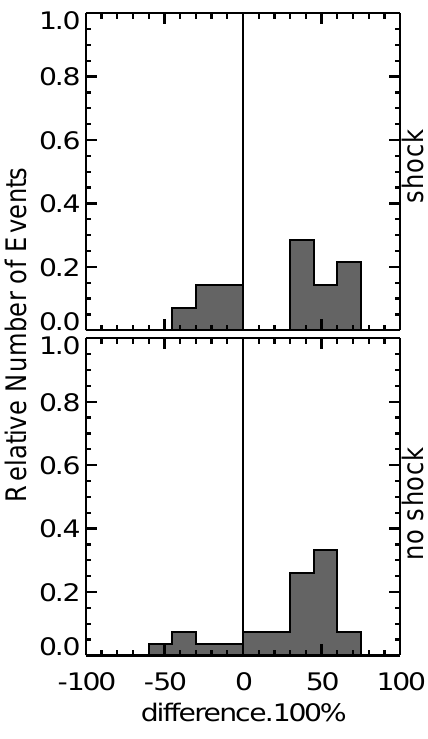
Fig. 6. Histograms of differences between the compression width and its theoretical maximum for CIRs with simple